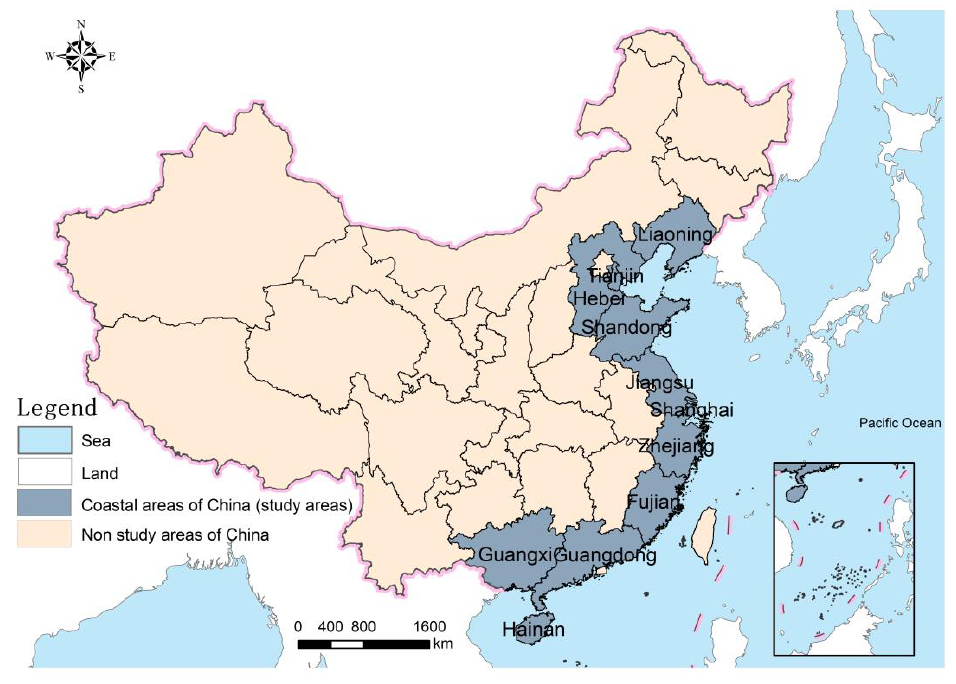
Figure 1. Location map of China’s coastal areas .